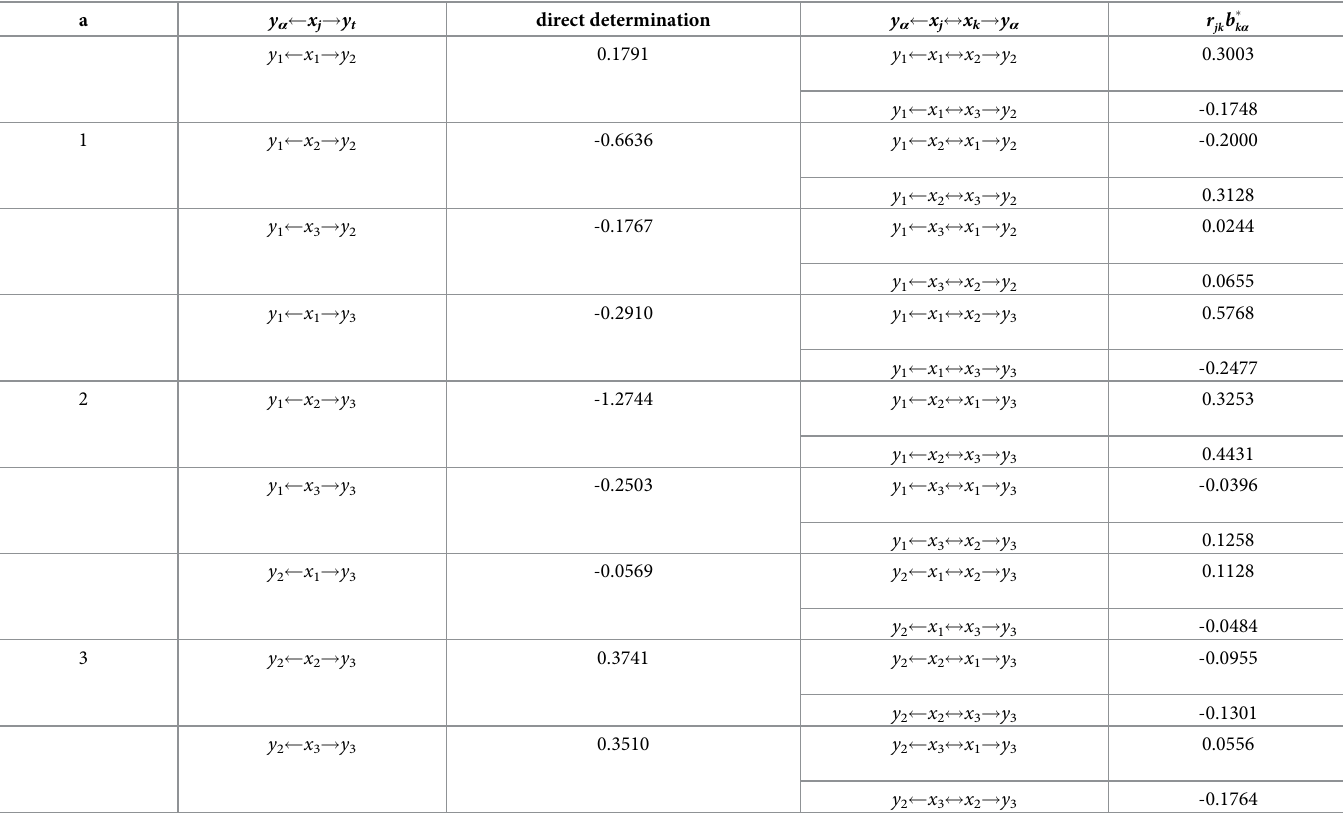
Table 5. The division results about three other types paths of the generalized determination